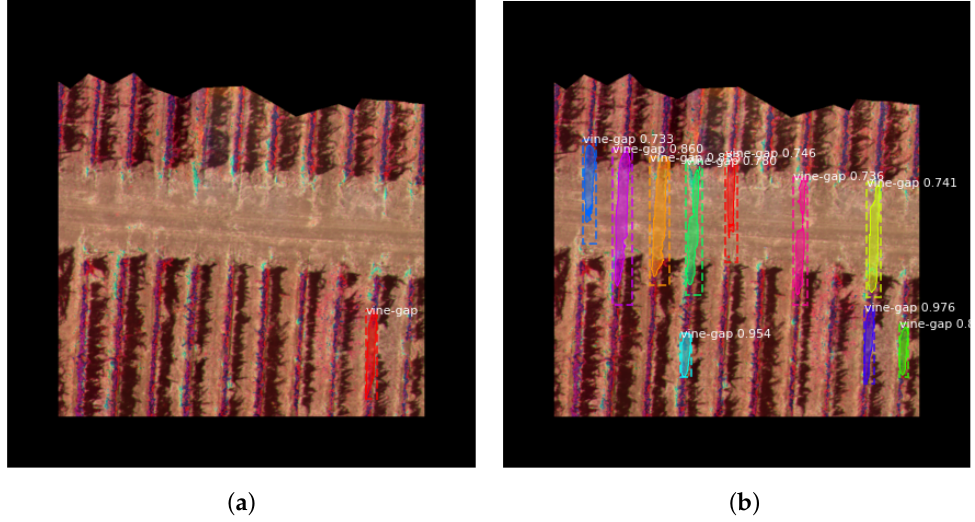
Figure 10. Examples of Mask-RCNN, after training ‘all’ layers for 50 epochs, miscategorizing the path. Dataset: CIR; Weights: Tiny YOLOv4; ( a ): original; ( b ):